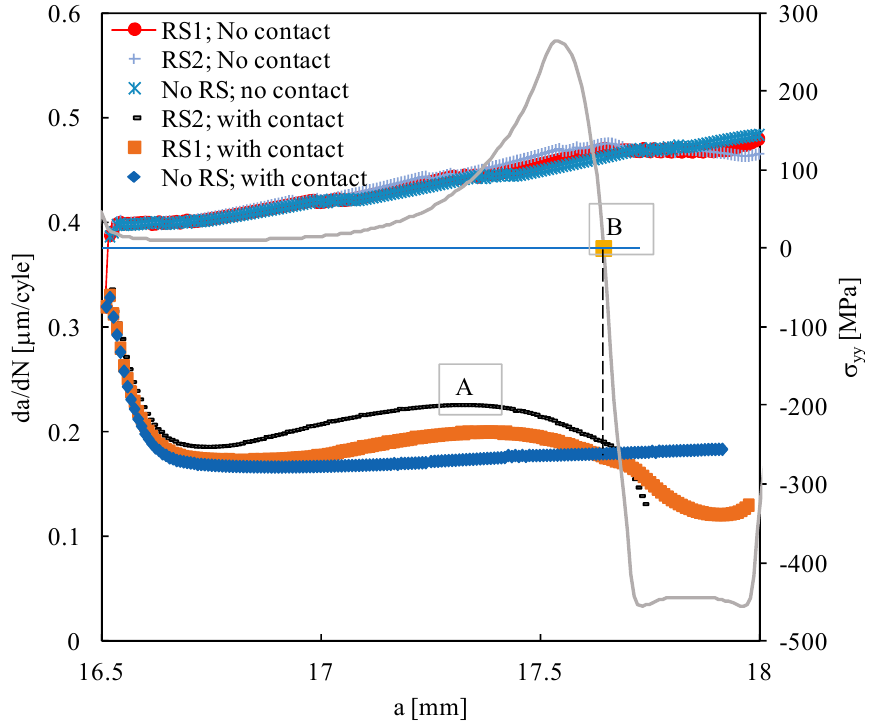
Figure 6. Fatigue crack growth rate versus the crack length for the residual stresses induced by plastic deformation (case B).